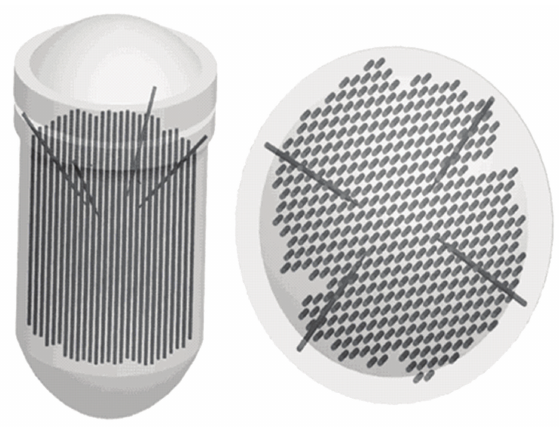
Figure 9: Boron lance location in core.